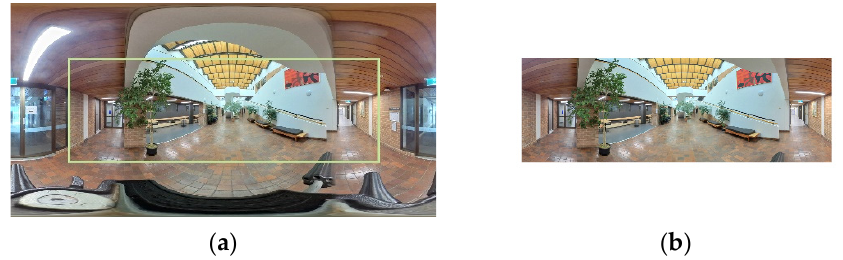
Figure 2. 360° panoramic image in interior space: ( a ) original image and ( b ) cropped image. Figure 2. 360 ◦ panoramic image in interior space: ( a ) original image and ( b ) cropped